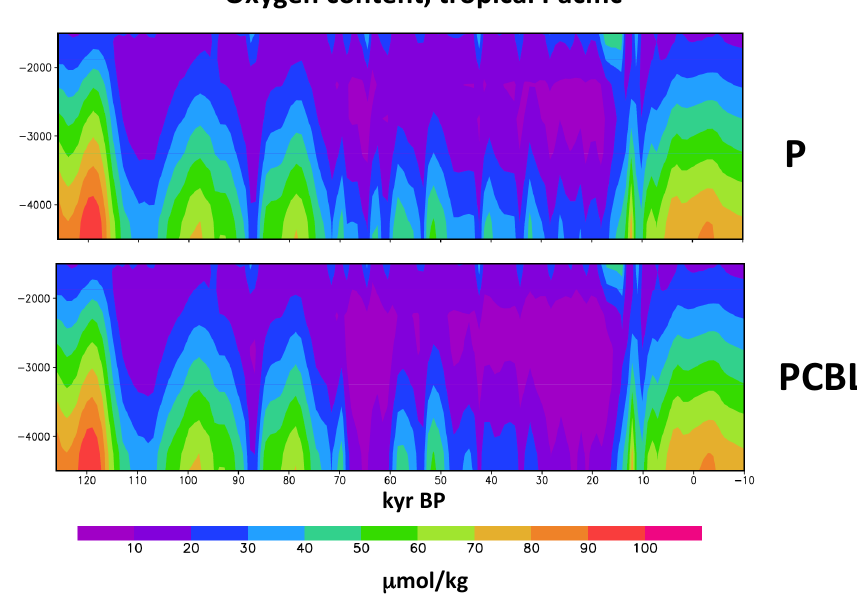
Fig. 10. Dynamics of the vertical distribution of the simulated O 2 concentration (µmolkg − 1 ) averaged over 30 ◦ S–30 ◦ N in the Pacific